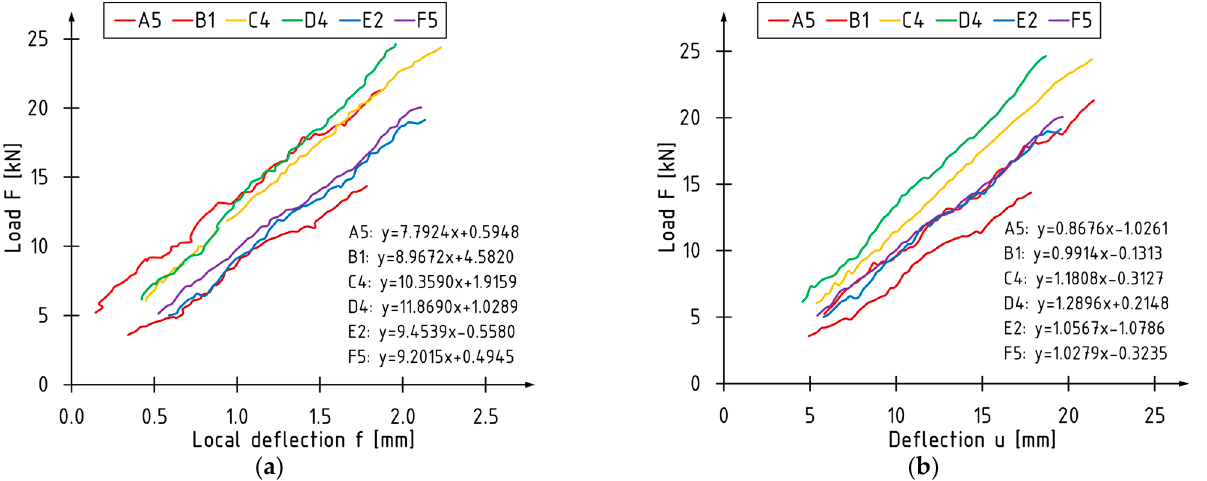
Figure 18. Relationship in range from 0.1 to 0.4 F max for: ( a ) load—local deflection; ( b ) load global deflection.